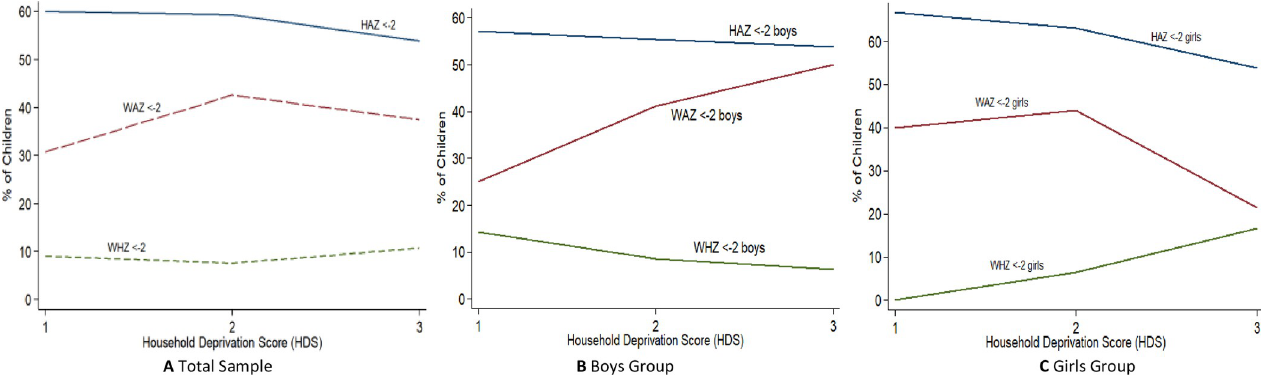
Fig 3. Prevalence rates of stunting, underweight and wasting for different HDS groups. A. Total Sample, B. Boys Group, C. Girls Group.